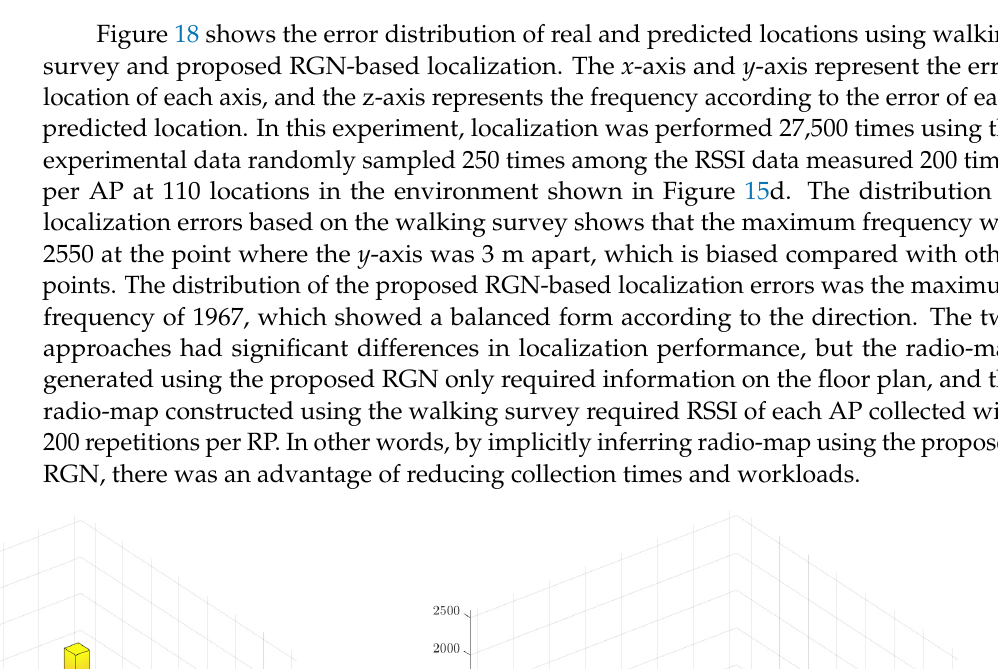
Figure 17. Comparison of CDF positioning errors between the proposed RGN and walking survey for varying numbers of installed AP.